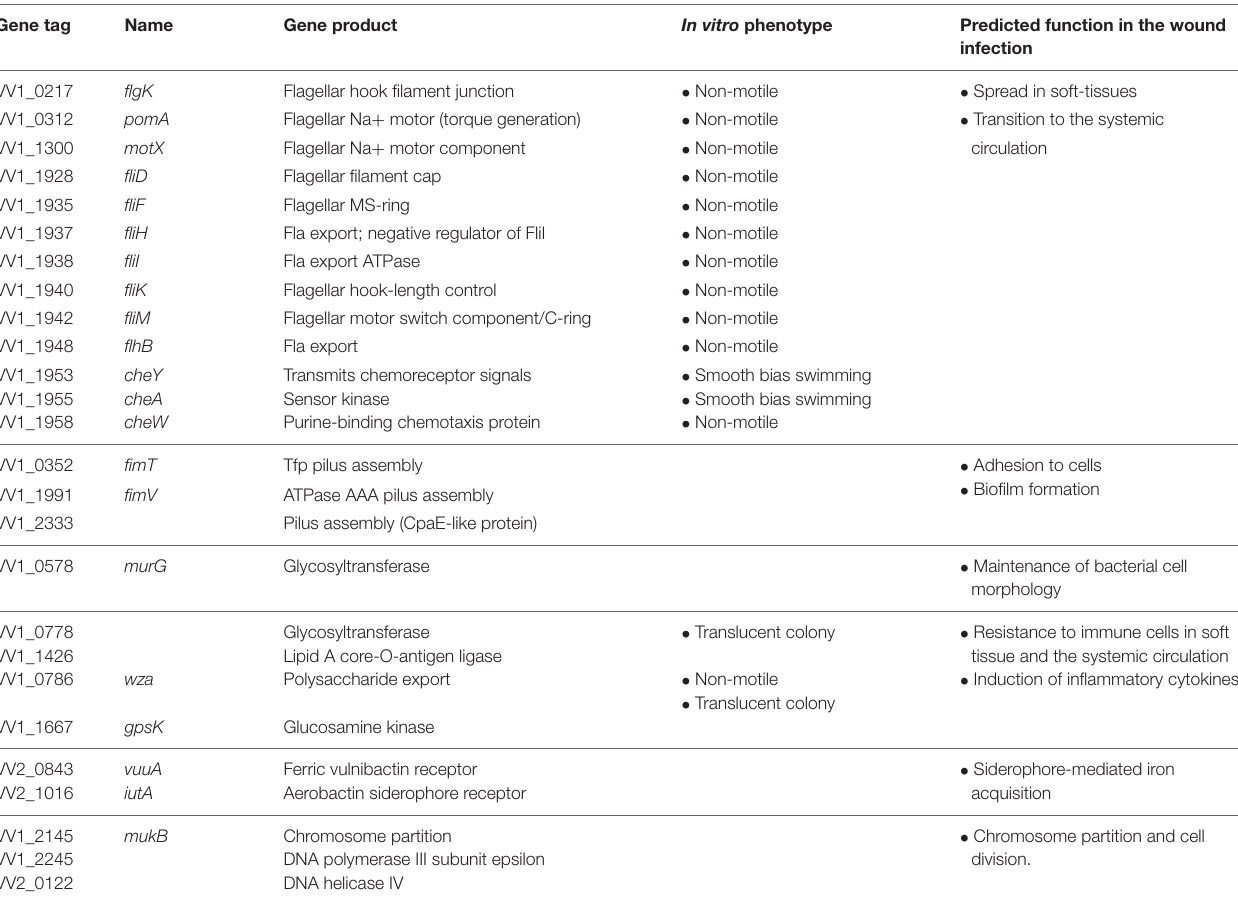
TABLE 1 | Genes involved in V. vulnificus wound